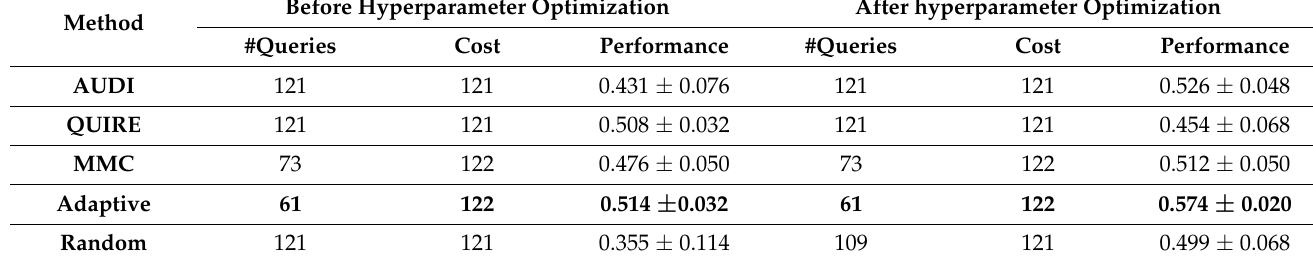
Table 6. Comparative evaluation of active learning selection methods in terms of accuracy (the best values are bold).